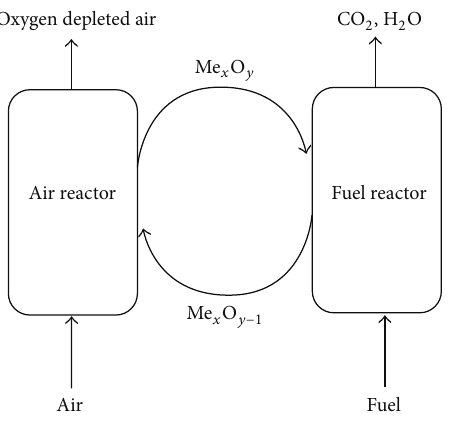
Figure 1: Schematic representation of a CLC unit.